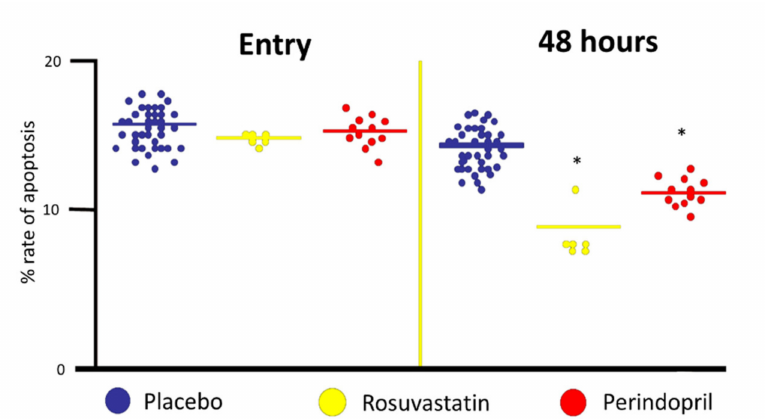
Figure 3. Effects of 48 h incubation of human endothelial umbilical cells (HUVECs) with serum from patients with acute ST-elevation myocardial infarction at entry (within 3 h from symptoms) and 48 h later. Patients were treated with either rosuvastatin 20 mg or perindopril 10 mg. * p < 0.05, different from